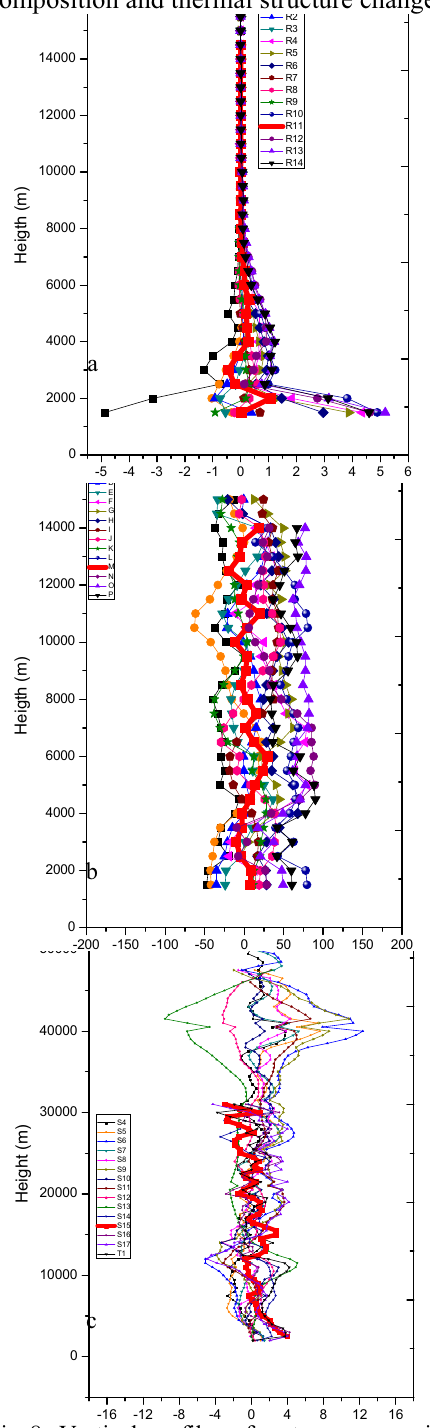
Fig 8: Vertical profiles of water vapour mixing ratio mean absolute BIAS (a) percentage BIAS (b) and vertical profiles of temperature mean absolute BIAS